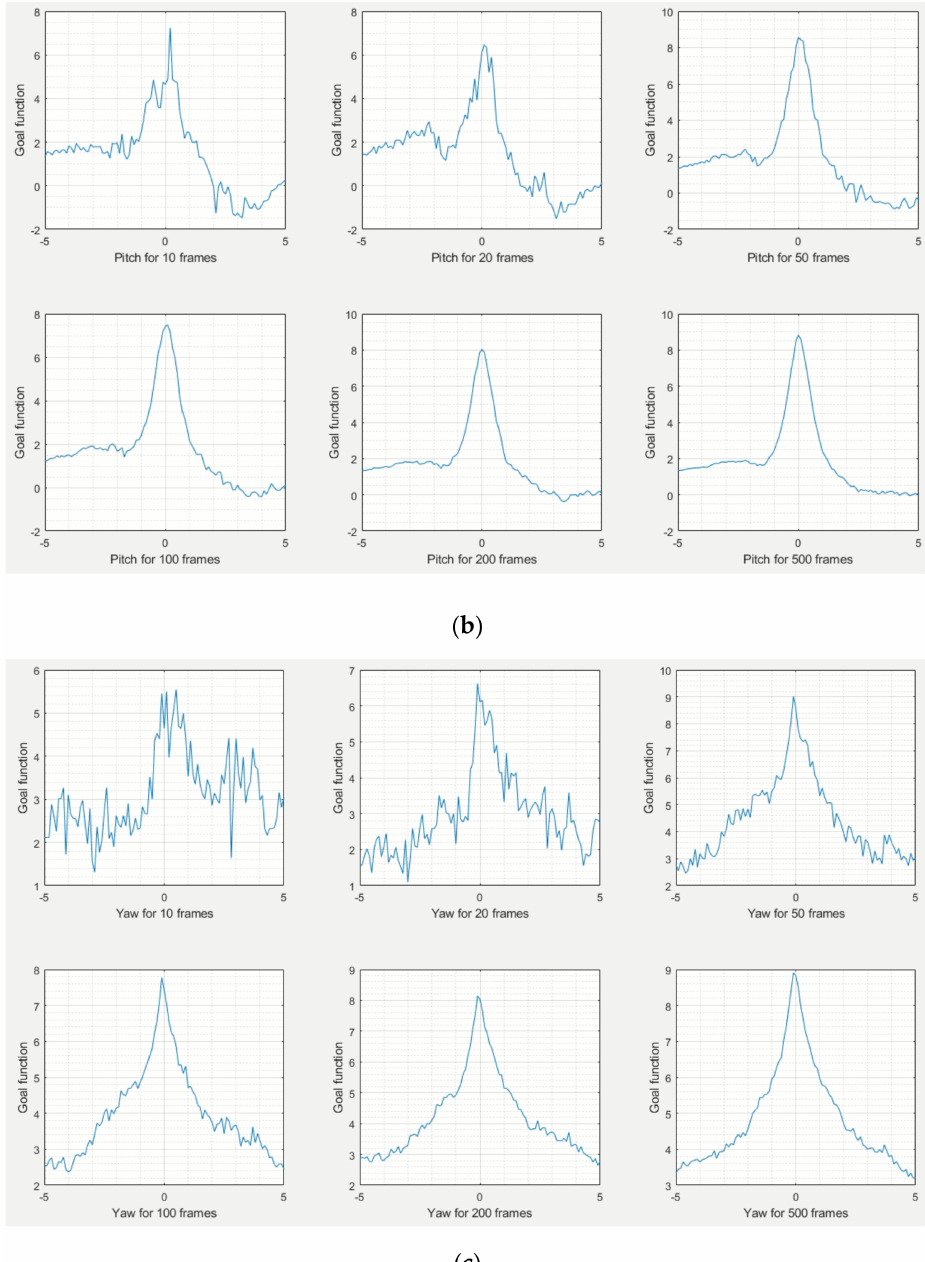
Figure 7. The goal function F as a function of roll ( a ), pitch ( b ), and yaw ( c ), with the other two angles set to zero. All angles are in